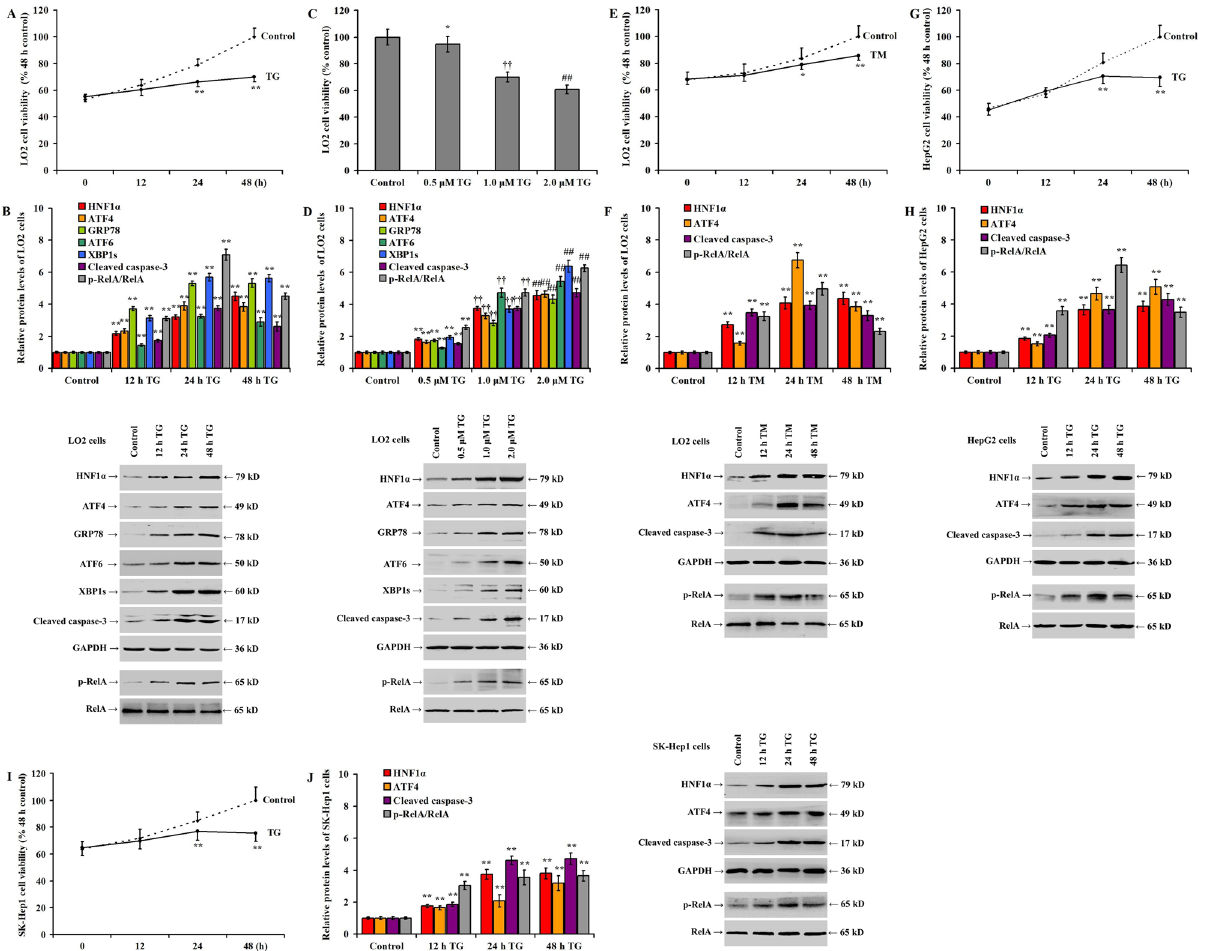
Figure 1. Significant apoptosis, HNF1α expression, and NF-κB activation in human-derived hepatocytes during ER stress. Human-derived hepatocytes were treated with TG in a time and dose-dependent manner and treated with dimethyl sulfoxide (DMSO) as a control: ( A ) LO2 cell viability as detected by MTS assay following treatment with TG (1.0 μmol/L) at different time points; ( B ) western blotting showing different protein expression and bar chart for relative protein expression following treatment with TG at different time points; ( C ) LO2 cell viability following ER stress induction by TG for 36 h in a dose-dependent manner; ( D ) western blotting showing the dose-dependent induced protein expression and bar chart for relative protein expression following TG treatment for 36 h; ( E ) cell viability in TM-induced LO2 cells; ( F ) western blotting and bar chart showing relative protein expression in TM-induced LO2 cells; ( G ) cell viability in TG-induced HepG2 cells; ( H ) western blotting and bar chart showing relative protein expression in TG-induced HepG2 cells; ( I ) cell viability in TG-induced SK-Hep1 cells; and ( J ) bar chart and western blotting showing relative protein expression in TG-induced SK-Hep1 cells. * p < 0.05, ** p < 0.01 versus the control group. †† p < 0.01 versus the 0.5 μmoL/L TG group. ## p < 0.01 versus the 1.0 μmol/L TG group. μM: